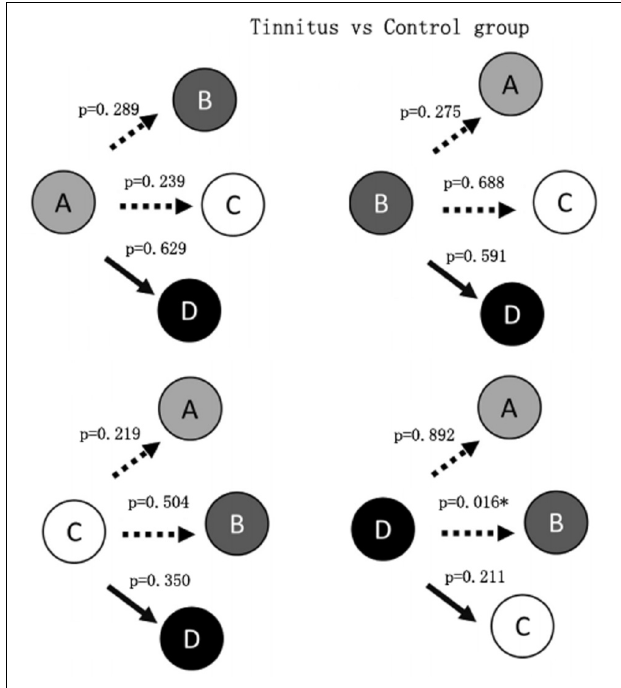
FIGURE 2 | Schematic view of the syntax pattern. ∗ Indicates significant difference ( p < 0.05).